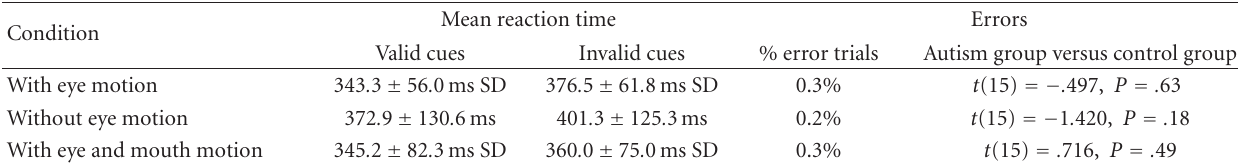
Table 3: Data on participants’ reaction times: mean reaction times, proportions of trials with errors, and t -tests for di ff erences in mean reaction times between